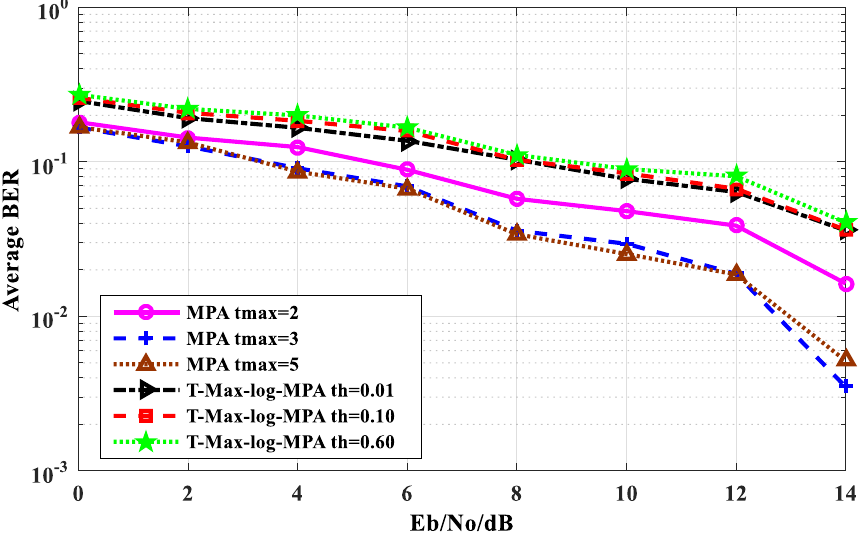
Figure 6. The Comparison of BER performance between the MPA algorithm and the Threshold-Max- log-MPA algorithm.